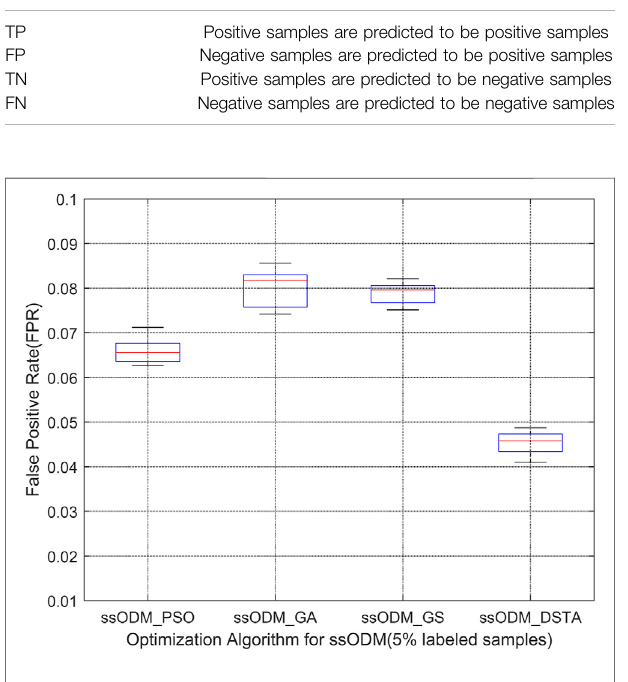
FIGURE 3 | Boxplot of FPR of fault detection regarding the pitch emergency stop (5% labeled samples).